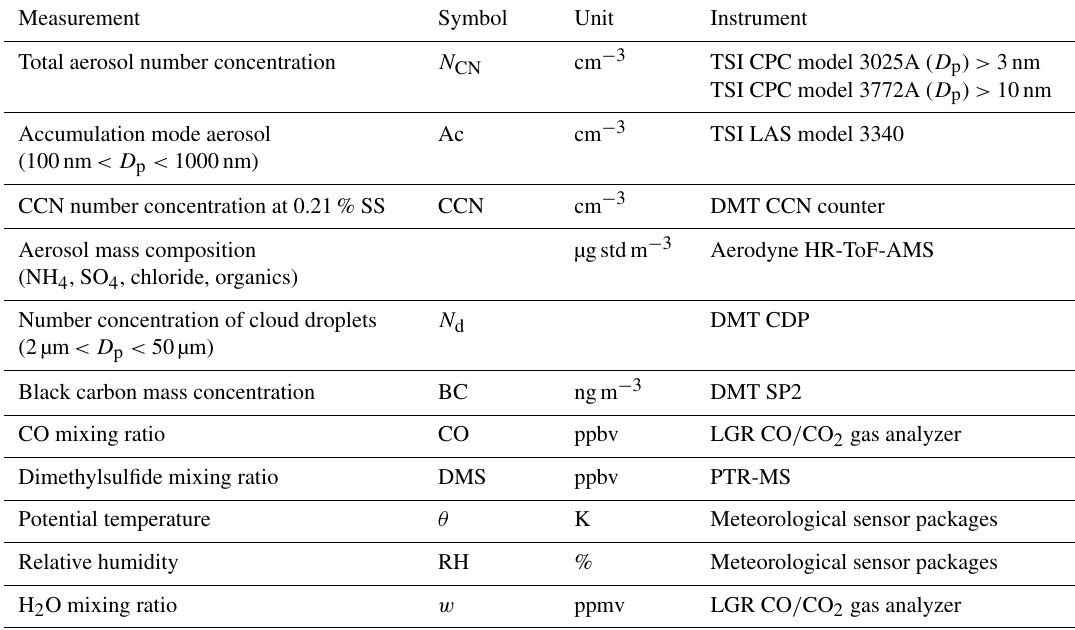
Table 2. Measurements of aerosol and cloud properties on the C-130 used in this study.